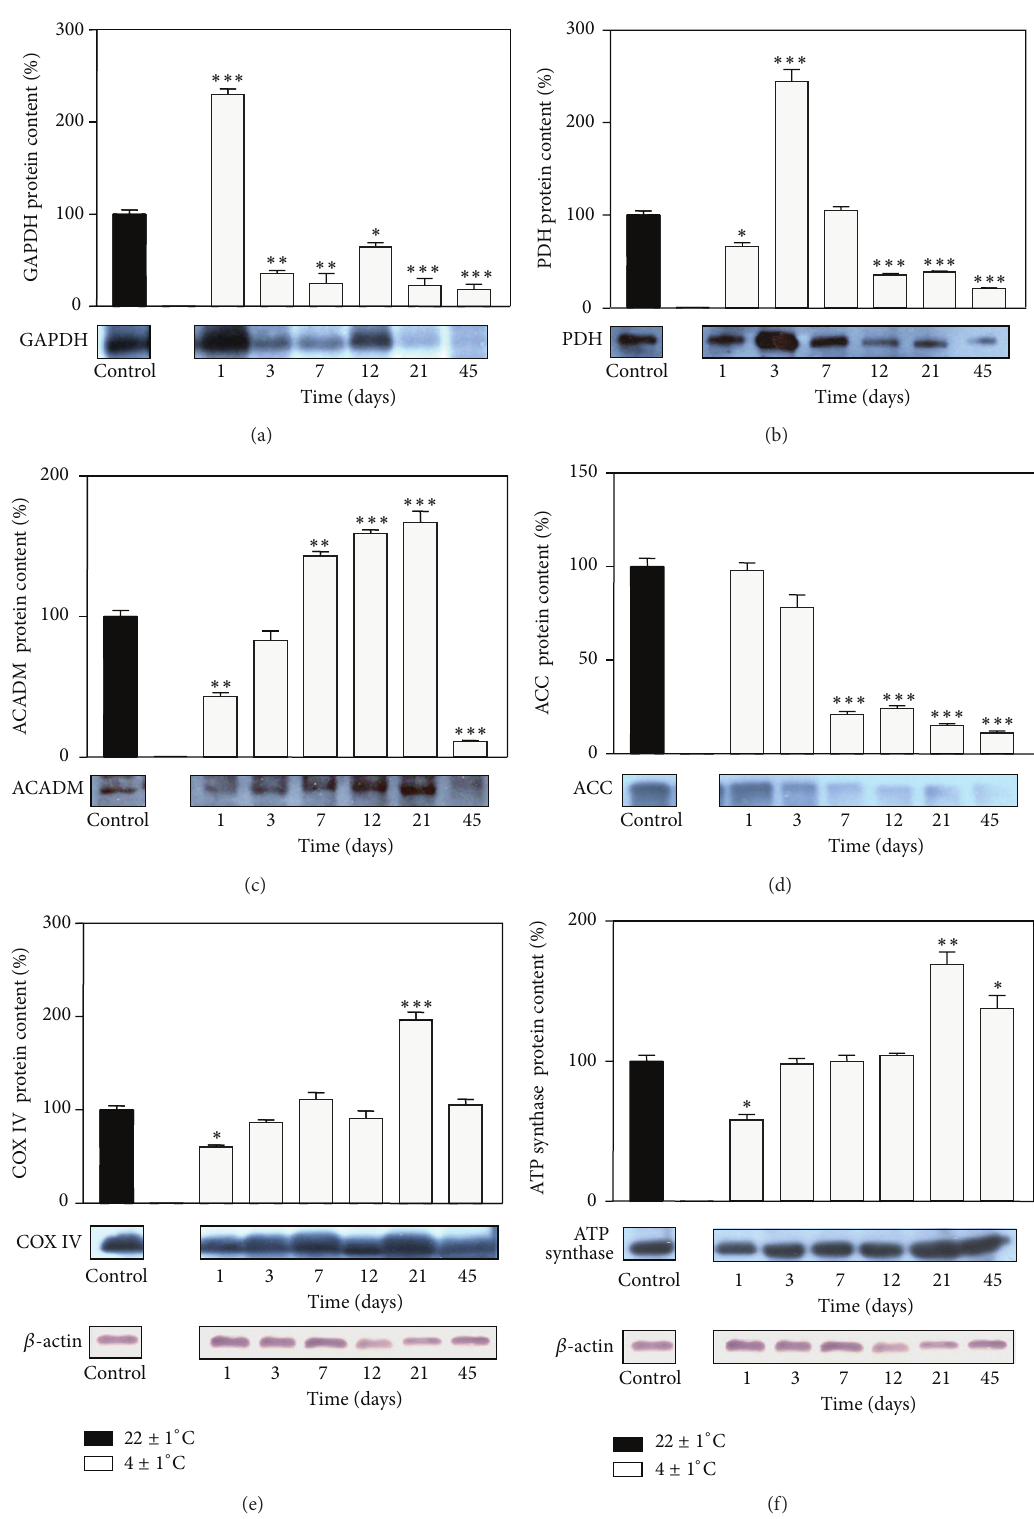
Figure 3: Changes in GAPDH (a), PDH (b), ACADM (c), ACC (d), subunit IV of cytochrome 𝑐 oxidase (COX IV) (e), and ATP synthase (f) protein levels in rat retroperitoneal depot of white fat tissue after different time periods of cold exposure. Protein content is expressed relative to the control maintained at room temperature, which was standardized as 100%. The results of the representative example from three observations are shown. Data were quantified as described in Section 2. The values represent the mean ± S.E.M. ∗ Compared to control, ∗ 𝑃 < 0.05 , ∗∗ 𝑃 < 0.01 , and ∗∗∗ 𝑃 < 0.001